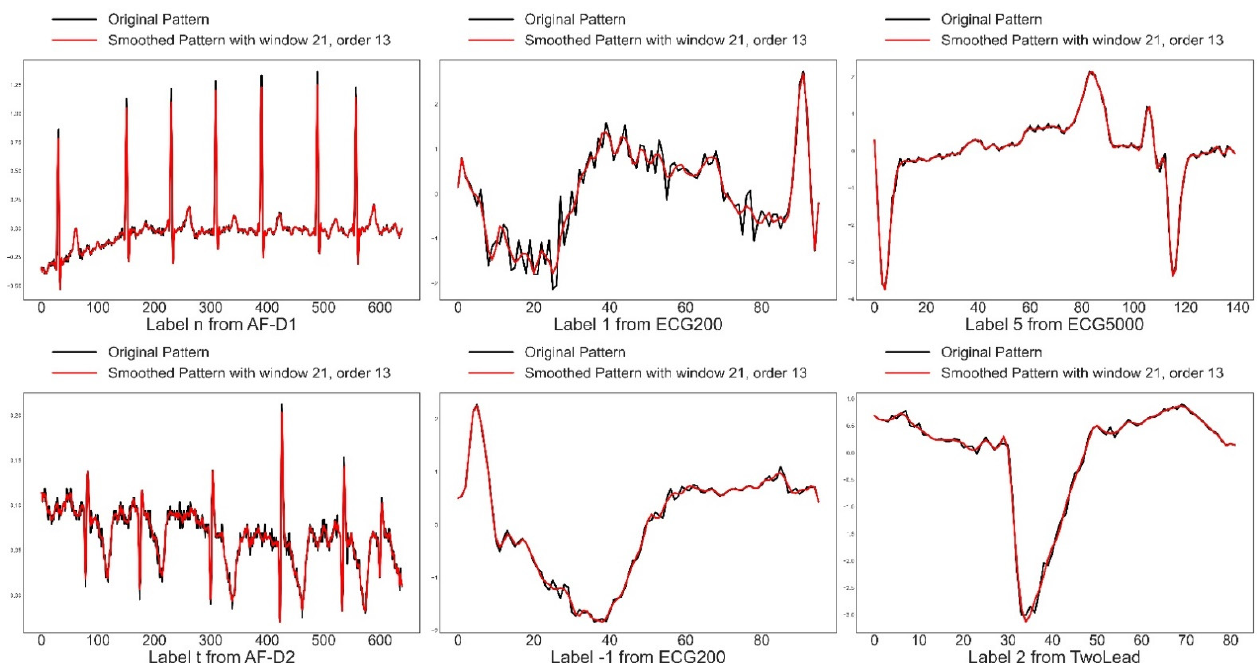
Figure 2. Original (black) and smoothed (red) pattern samples from five datasets used in the experiments. Smoothed patterns were generated by Savitzky–Golay filter with window size 21 and polynomial order 13.